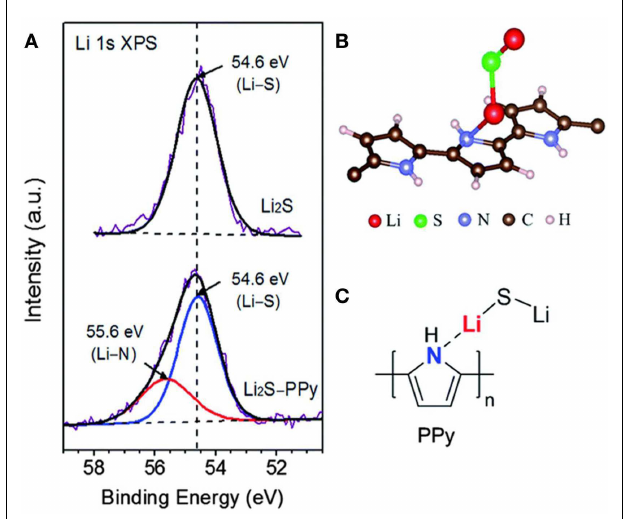
FIGURE 7 | (A) High-resolution Li 1S XPS spectra of bare Li 2 S and Li 2 S–PPy composites, (B,C) molecule simulation of stable bond between Li 2 S and PPy (Seh et al., 2014).